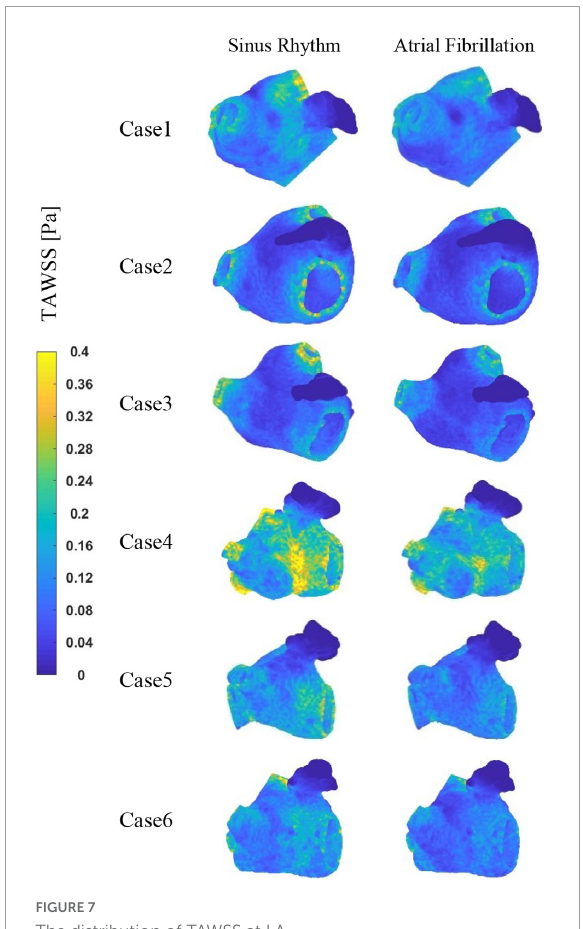
FIGURE7 The distribution of TAWSS at LA.